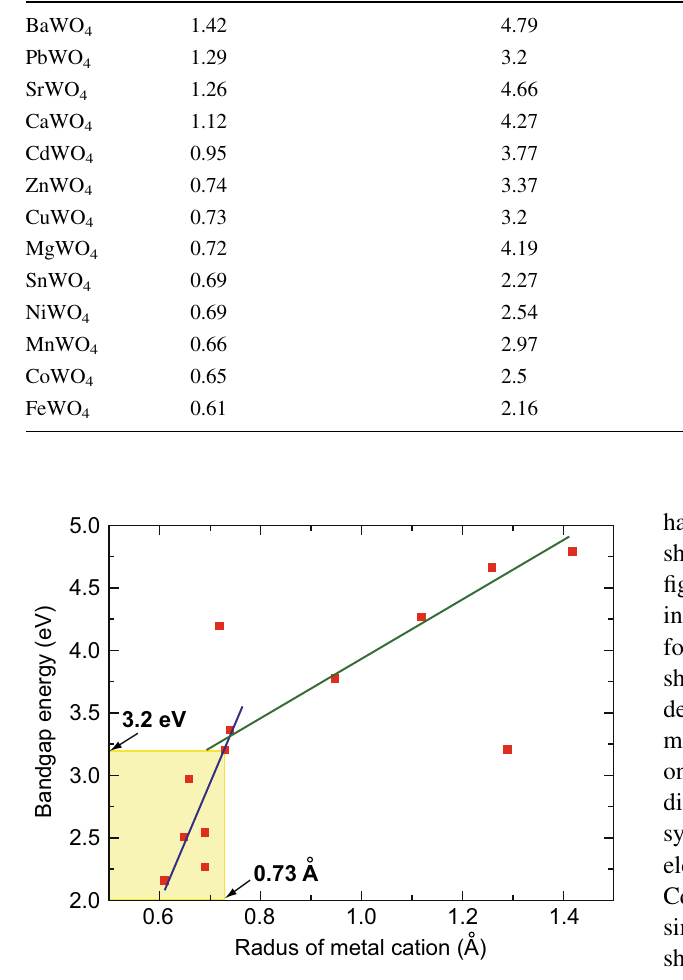
Fig. 4 Relationship between band-gap energy of MWO 4 and the radii of metal